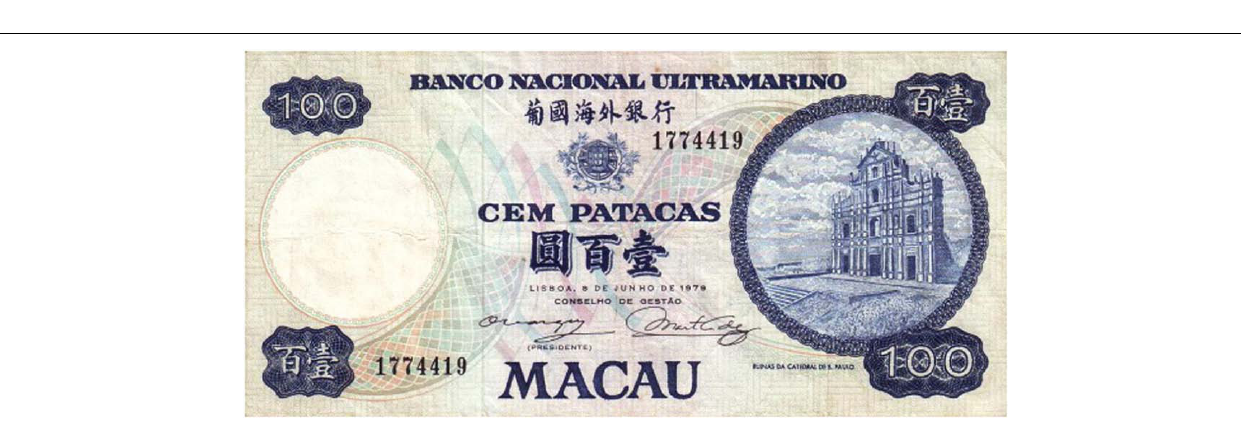
FIGURE 4 |The 1973 version of the 100 Macanese pataca banknote. The Chinese name of the issuing bank had changed to the newer LR direction, but the denomination